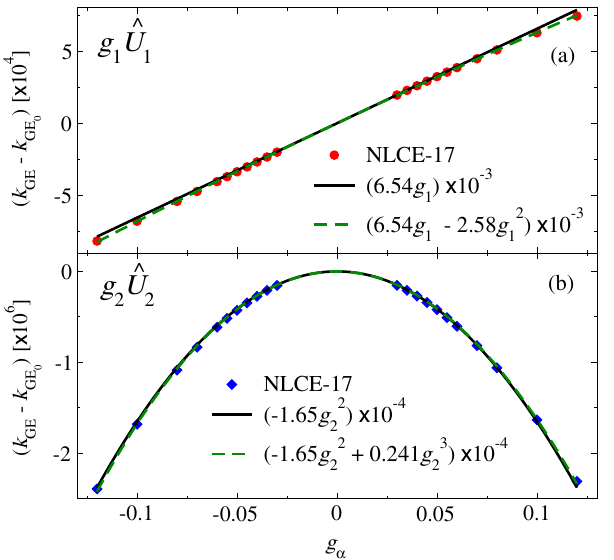
FIG. 4. Difference in the equilibrium (grand canonical ensem- ble) results between the actual dynamics (GE) and the projected dynamics (GE 0 ) for the one-body nearest neighbor correlation − k ( k evaluated at the 17th order of the NLCE. (a) g 1 GE GE 0 Þ perturbation (symbols), with linear and linear plus quadratic fits ˆ V (lines). (b) g 2 2 perturbation (symbols), with quadratic and quadratic plus cubic fits